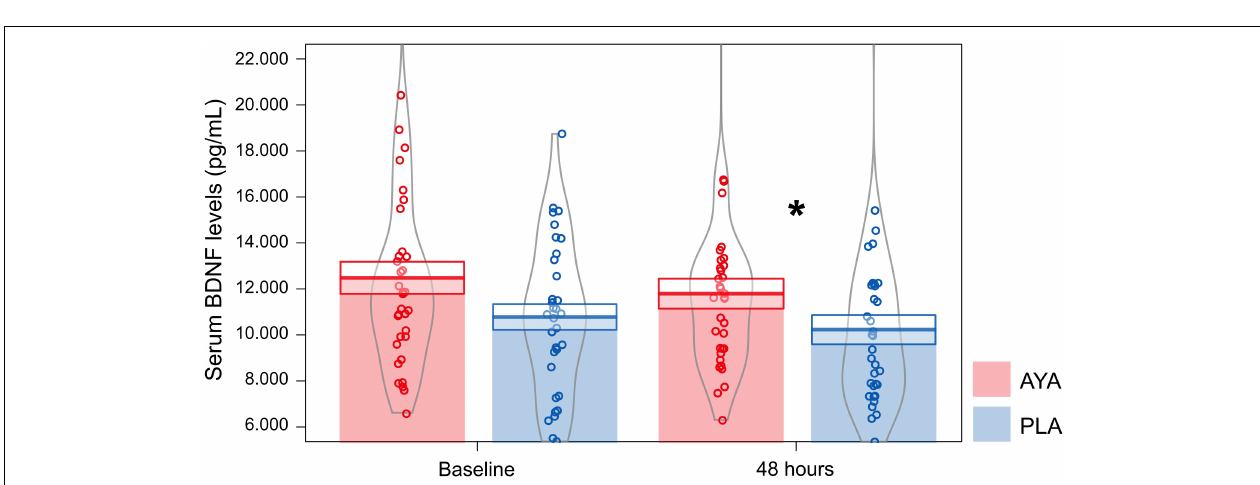
FIGURE 4 | Mean ± standard error of serum BDNF levels (pg/mL) for volunteers of ayahuasca (AYA: red color, n = 35) and placebo (PLA: blue color, n = 34) treatments at baseline (D0) and 48 h after dosing (D2). GLM test and Fisher post hoc , ∗ p ≤ 0.05, statistically significant difference between-groups. The curvilinear gray lines represent the density of samples distribution. The circles represent individuals in each group.